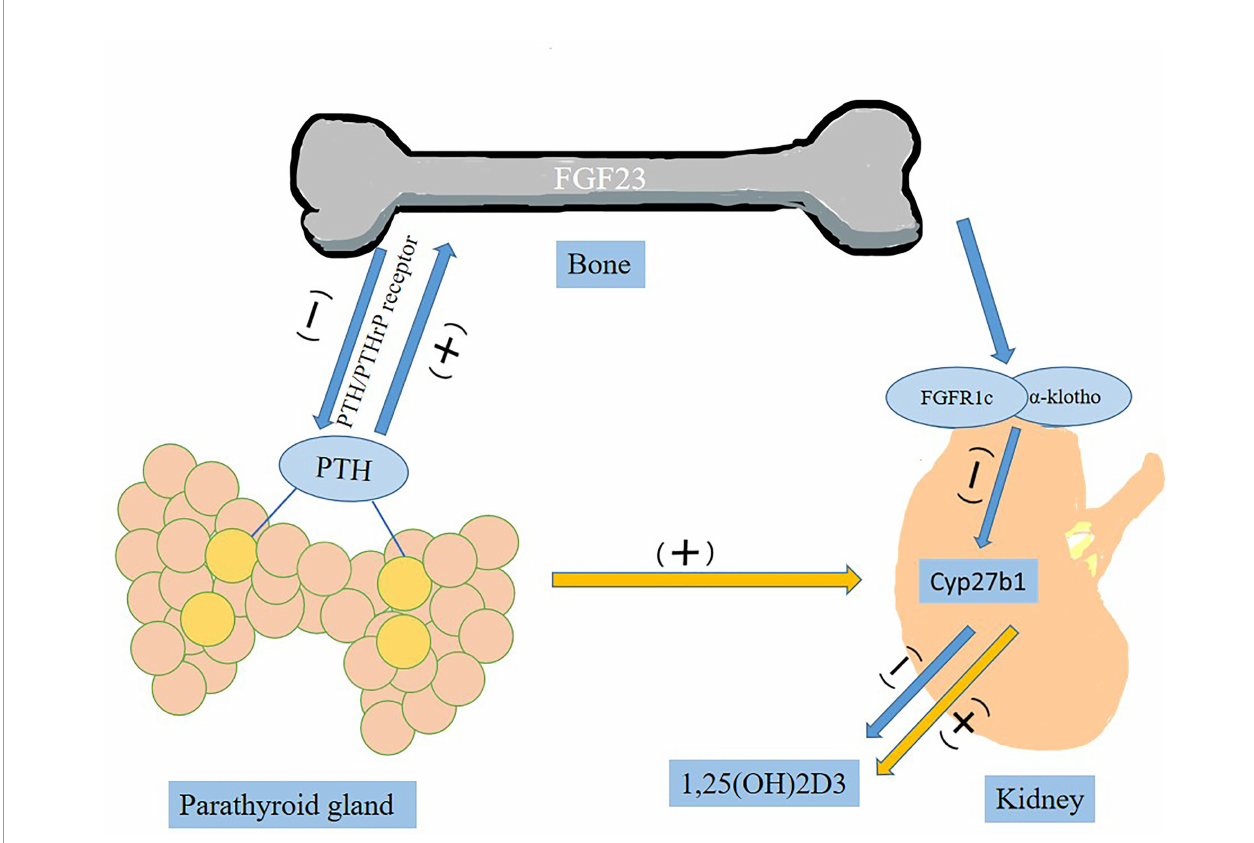
FIGURE 1 | The role of FGF23 in the